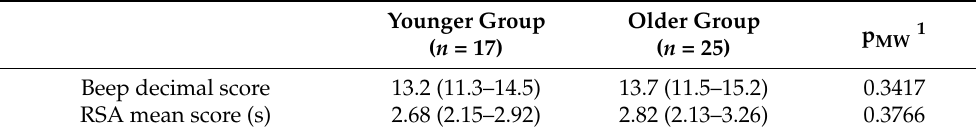
Table 4. The results of the tests performed by the